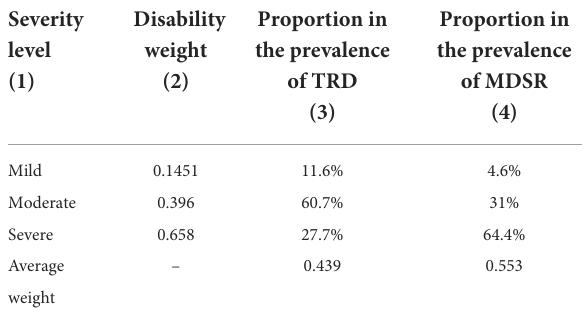
TABLE 2 Disability weights considered in the burden of disease